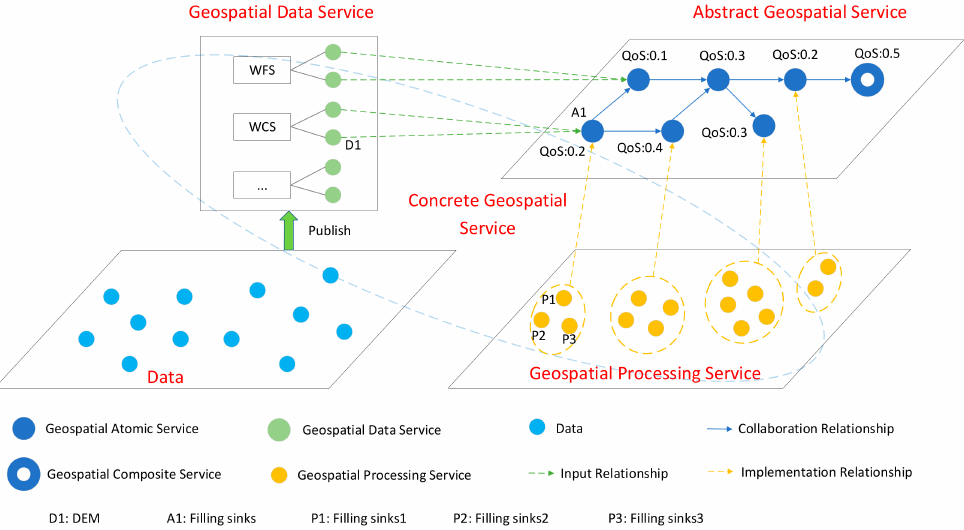
Figure 2. Logic structure diagram of